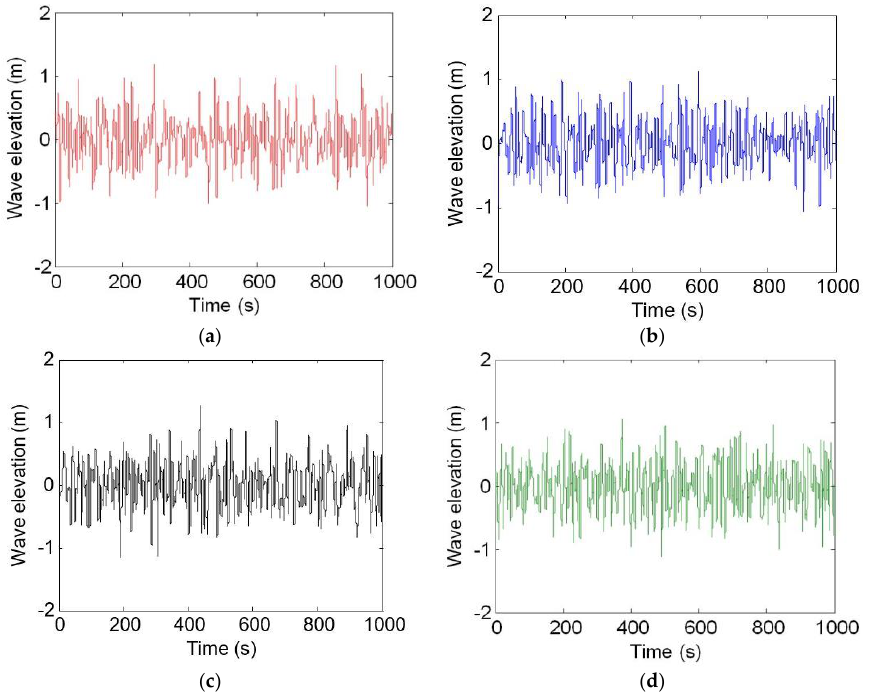
Figure 13. Wave elevation graphs for random waves with equal significant wave height and peak frequency values of ( a ) 0.83 Hz; ( b ) 0.77 Hz; ( c ) 0.71 Hz; ( d ) 0.61